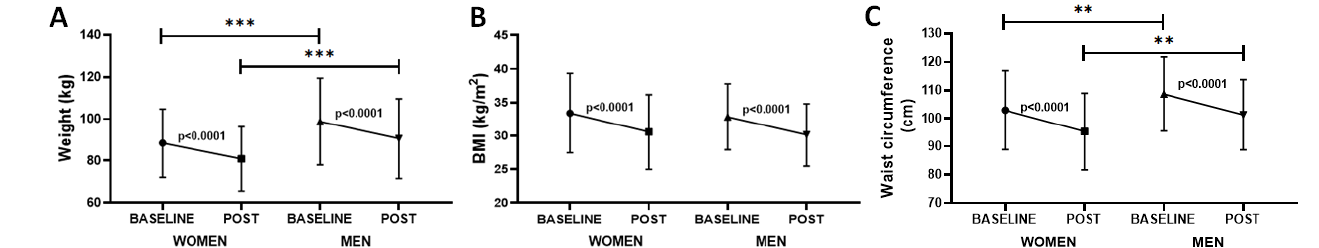
Figure 3. Representation of variation in weight (kg, ( A )), BMI (kg/m 2 , ( B )), and waist circumference (cm, ( C )), presented as the mean and SD, of the volunteers enrolled in the present study separated into women and men, both before (BASELINE) and after (POST) 4 Phases Methodology application. ** p < 0.01 *** p < 0.001